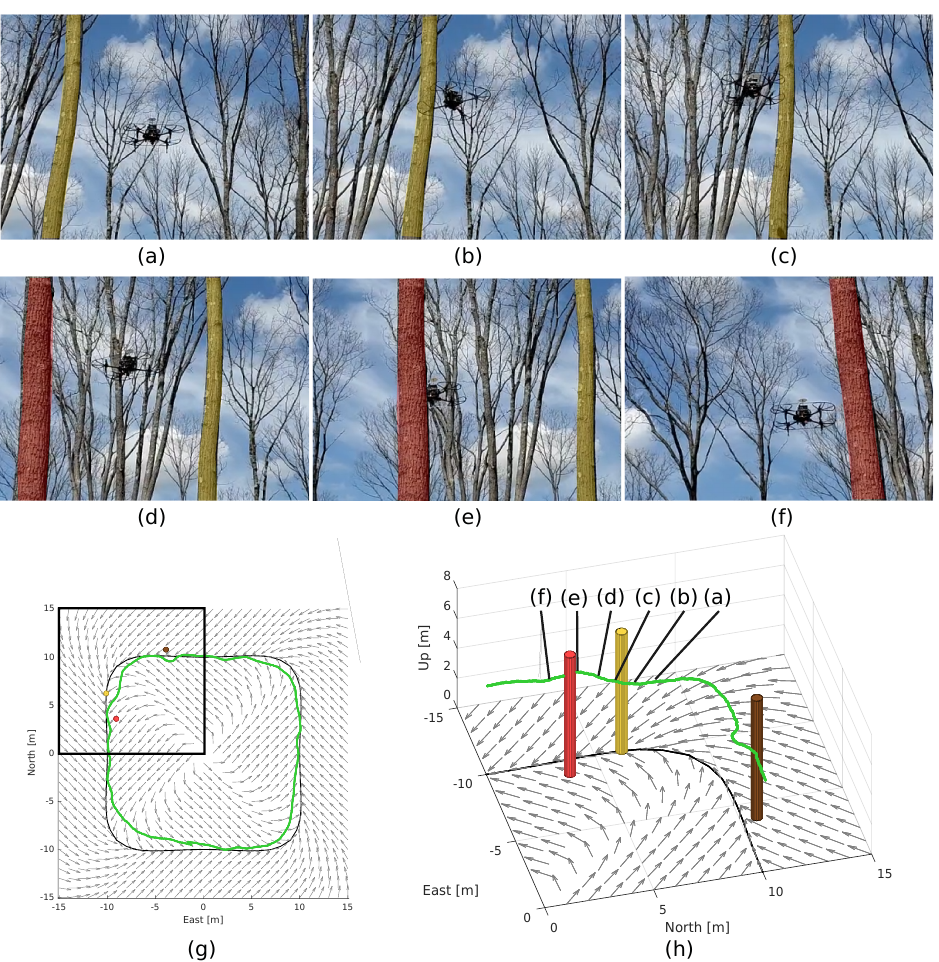
Figure 16. Results of an experiment performed with a drone in a forest. ( a – f ) shows snapshots of the part of the experiment highlighted in the black box of ( g ). In ( g , h ), the vector field is shown by